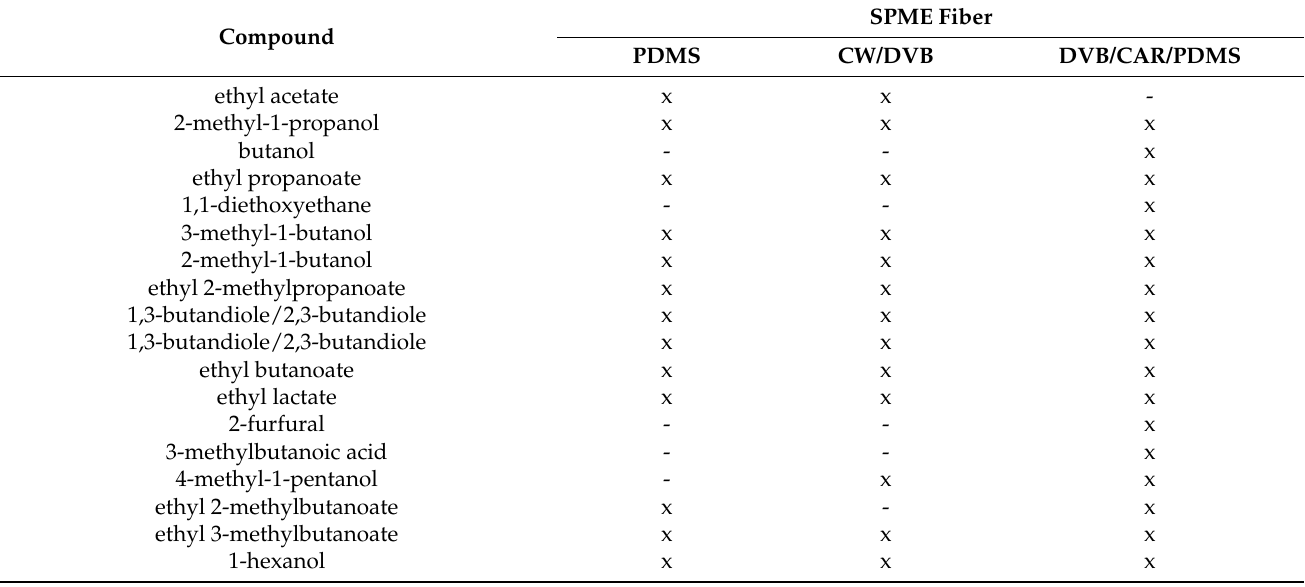
Table 1. List of the volatile compounds detected (x) in wine aroma by means of different SPME fibers.